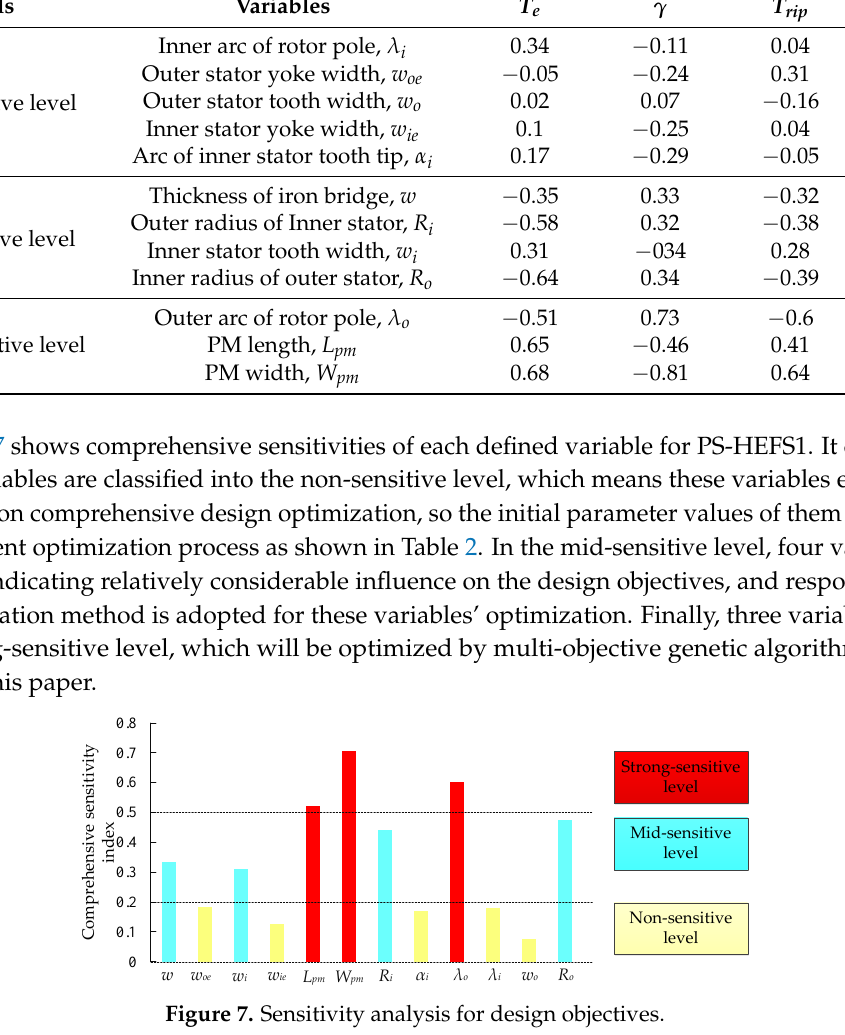
Table 1. Sensitivities for design variables